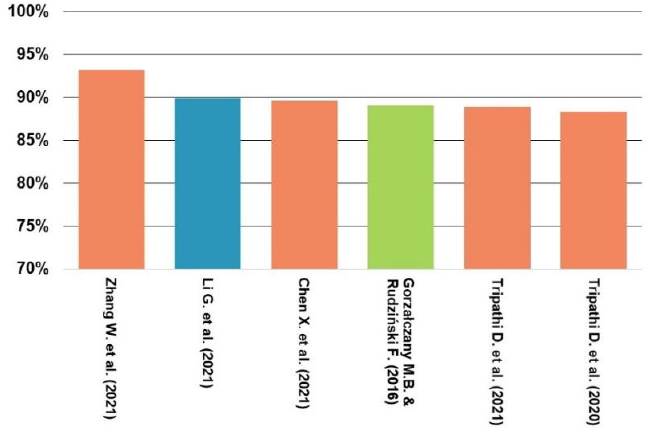
Figure 15. Comparison of accuracy of various methods for the Japanese dataset.